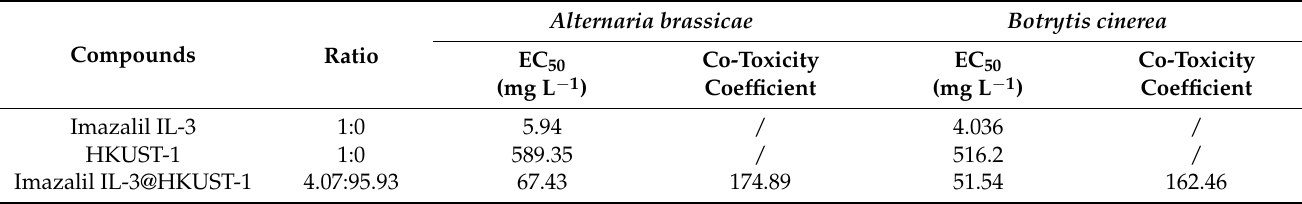
Table 3. Co-toxicity of the imazalil IL-3@HKUST-1 to Alternaria brassicae and Botrytis cinereal